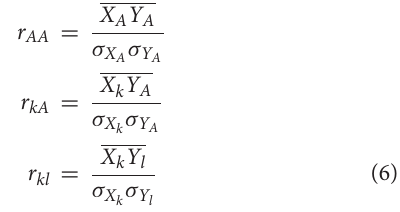
skill. Bigger discrepancies very likely exist for other variables, such at precipitation, but this is not pursued